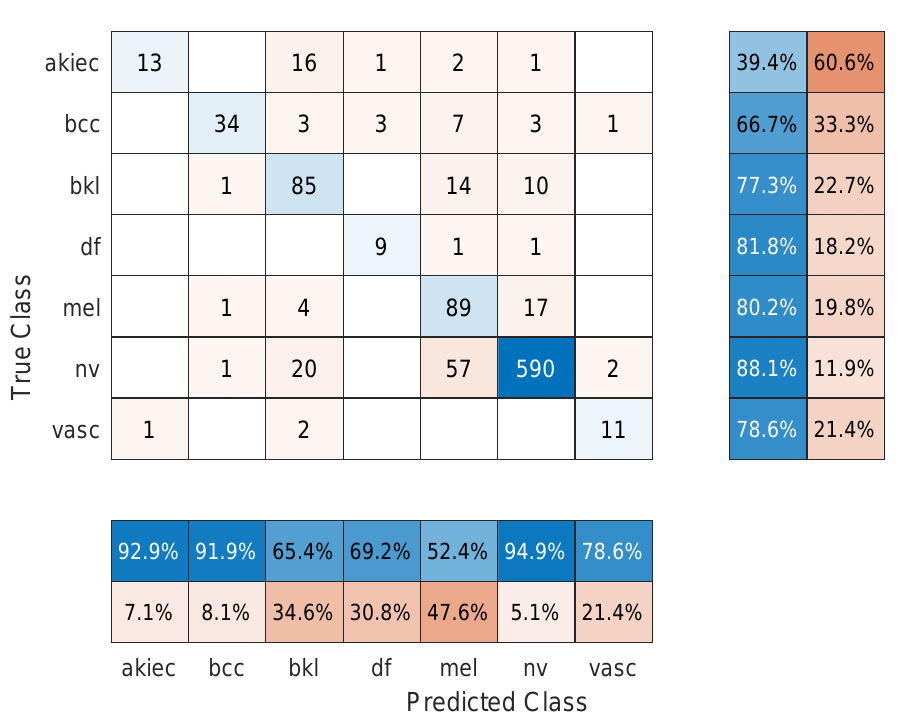
Figure 10. Sample confusion matrix for DarkNet-53 model, 90/10 data split and 50 epochs of